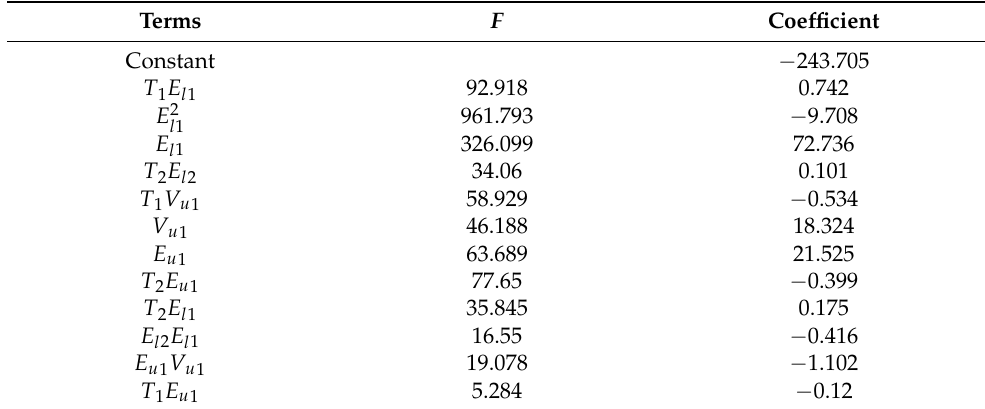
Table 7. Significance of the terms of Equation (8). (Adapted from Table S3.27 in [27], Supplementary Material (“S3.docx” file)).